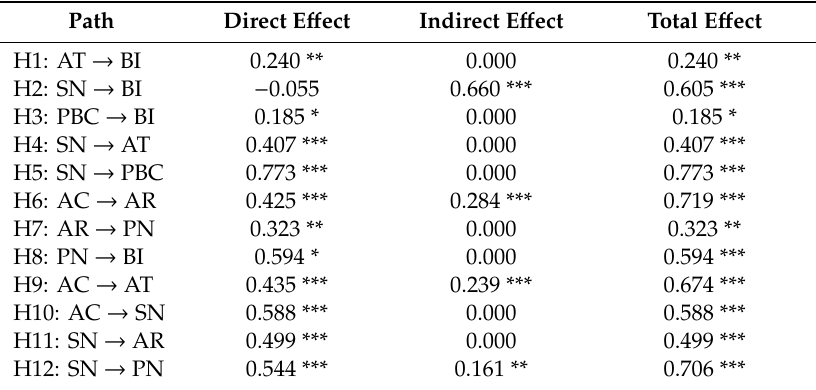
Table 5. Direct e ff ect, indirect e ff ect, and total e ff ect test